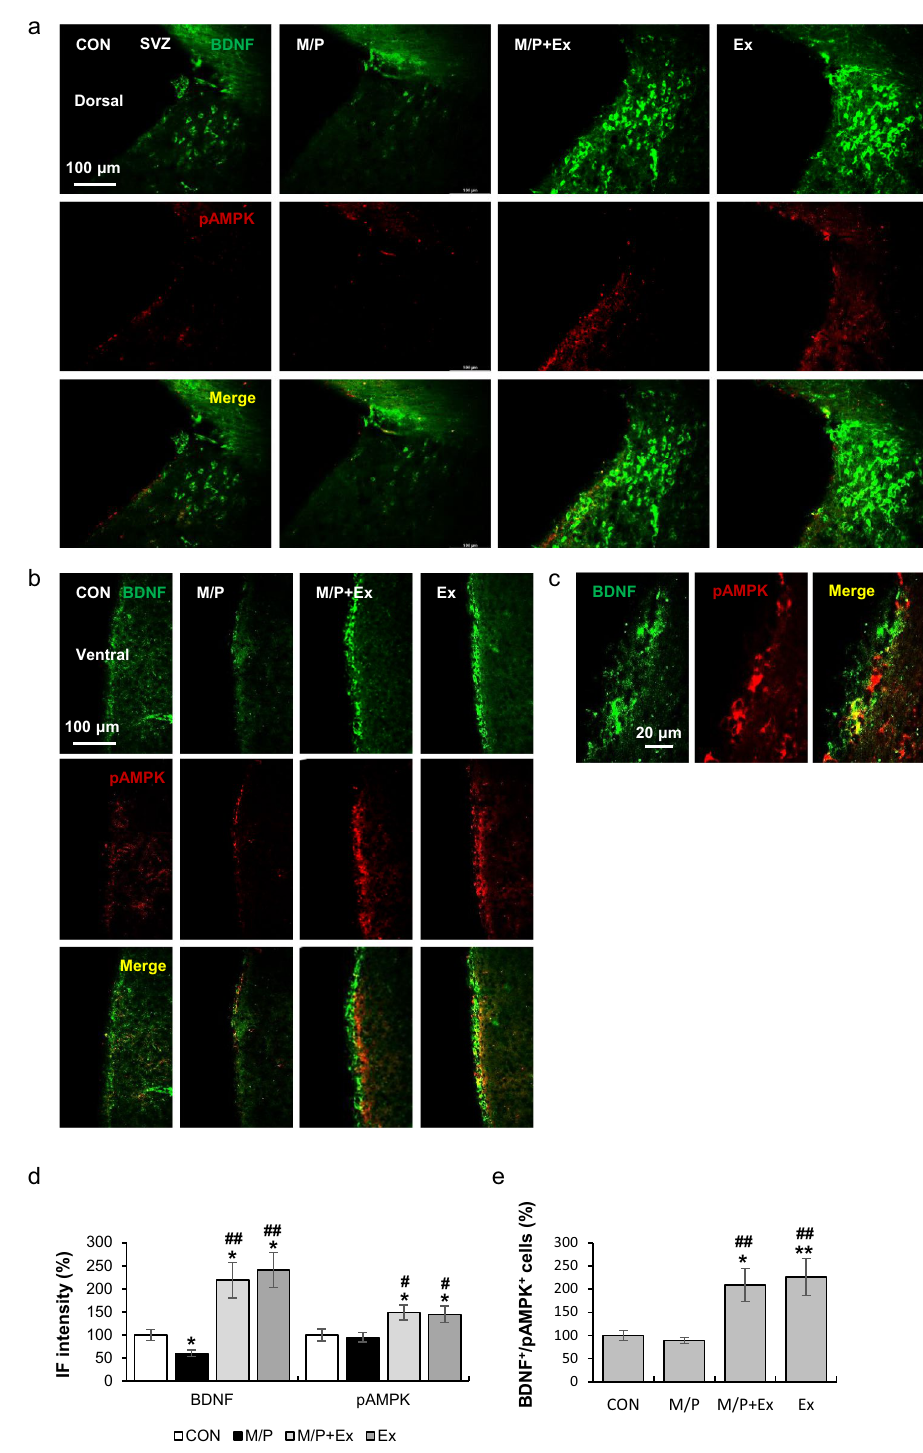
Figure 3. Rotarod walking exercise activated the AMPK/BDNF pathway in the SVZ area of M/P-treated mice. ( a ) Photomicrographs of the double fluorescent staining of dorsal SVZ BDNF + and pAMPK + cells (CON, N = 8; M/P, N = 9; M/P + Ex, N = 9; Ex, N = 8, 200 × of magnification). ( b ) Photomicrographs of the double fluorescent staining of ventral SVZ BDNF + and pAMPK + cells (CON, N = 8; M/P, N = 9; M/P + Ex, N = 8; Ex, N = 9, 200 × of magnification). ( c ) Representative photomicrograph of the high magnitude of SVZ BDNF + /pAMPK + cells (400 × of magnification). ( d ) Quantification of the fluorescent intensity of SVZ BDNF + and pAMPK + particles showing that exercise restored the M/P-induced decrease in BDNF + , and enhanced the pAMPK + IF intensity, regardless of MPTP treatment (CON, N = 8; M/P, N = 9; M/P + Ex, N = 9; Ex, N = 8). ( e ) Quantification of the fluorescent staining of SVZ BDNF + /pAMPK + cells showing that exercise increased the number of BDNF + /pAMPK + cells, regardless of MPTP treatment. Data are presented as mean ± SEM. *p < 0.05, vs. CON; **p < 0.01, vs. CON; # p < 0.05, vs. M/P; ## p < 0.01, vs.